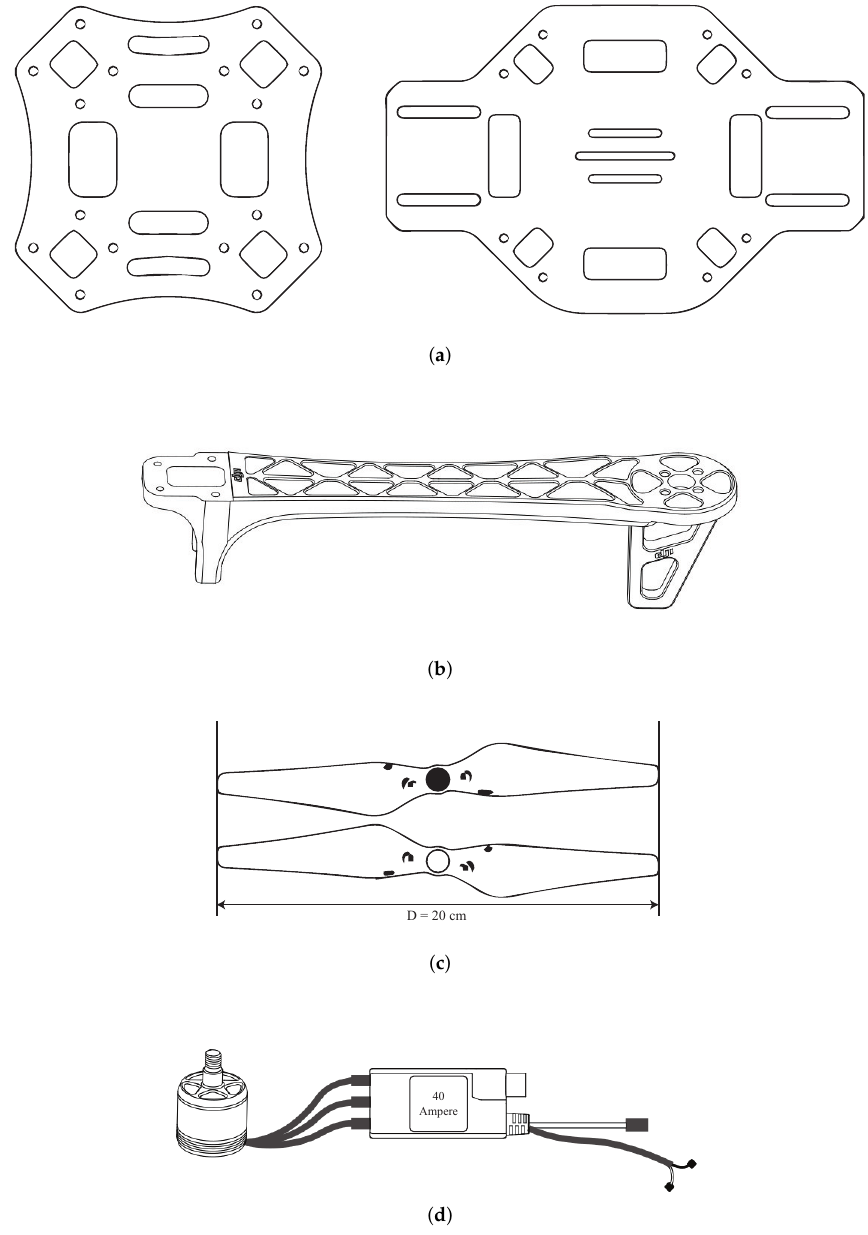
Figure 7. Components used to build the UAV: ( a ) central part of the chassis, ( b ) arms of the chassis where the motors are lodged, ( c ) propellers, and ( d ) 40 A ESC driver connected to the motors featuring K v = 1000